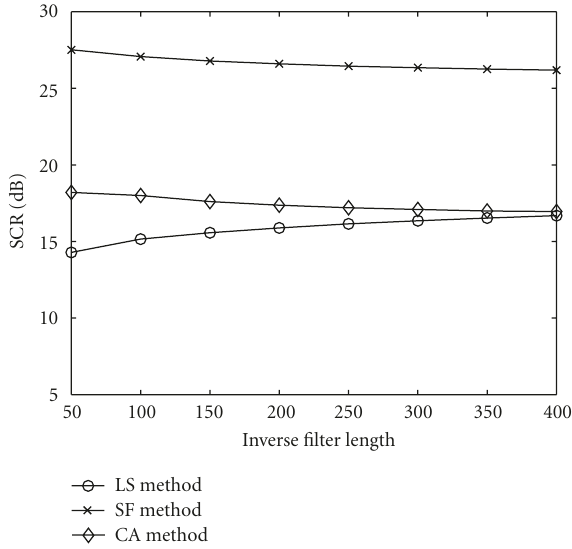
Figure 6: Mean signal-to-crosstalk ratio (SCR) at di ff erent inverse filter lengths for the three methods: the least-squares method (LS), the single-filter structure method (SF), and the CAPZ method (white noise added to HRTF).